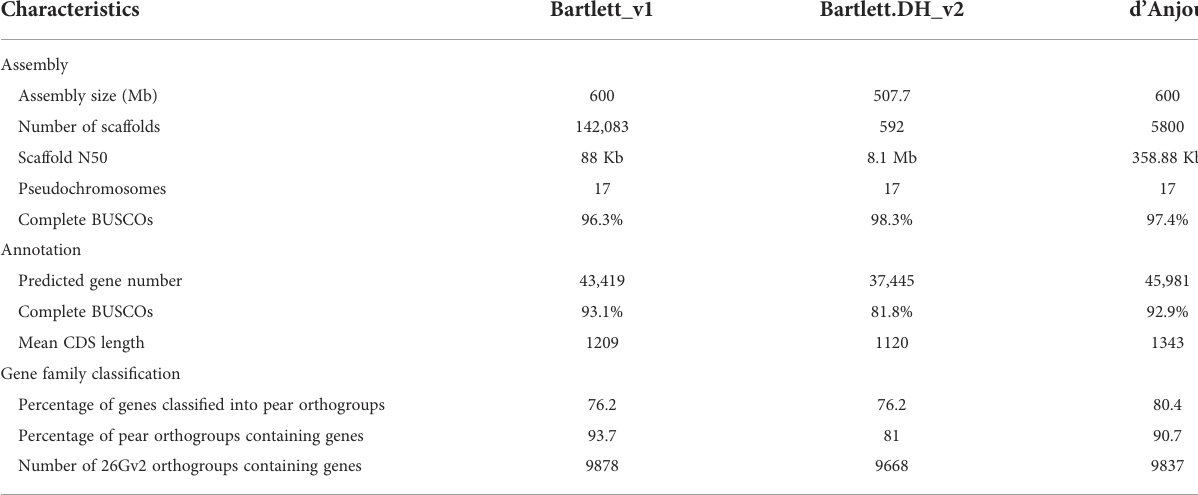
TABLE 1 Comparison of genome assembly and annotation, and orthogroups among Pyrus communis genotypes.